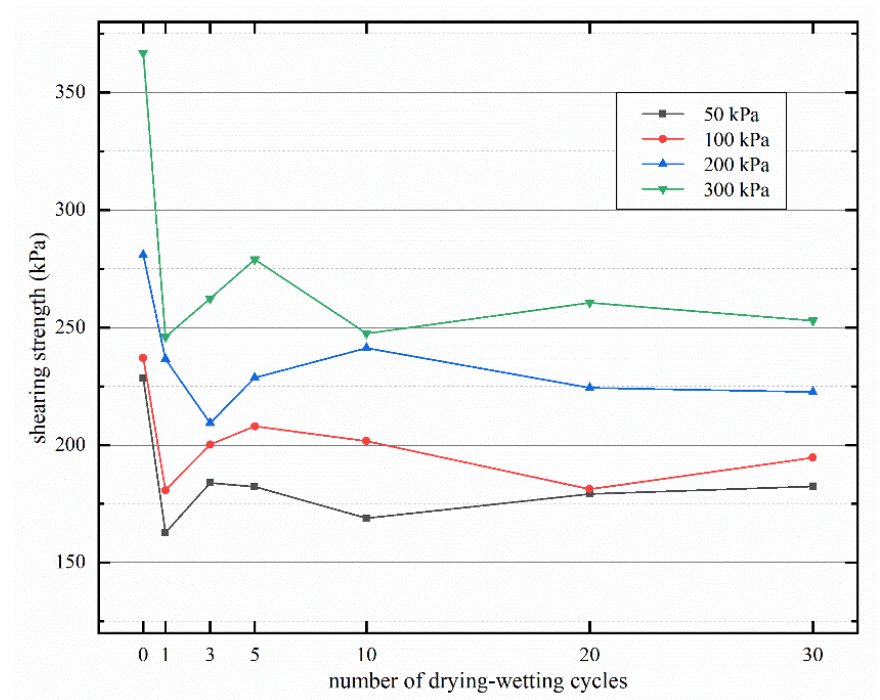
Figure 8. Variation of shear strength with the number of drying–wetting cycles.